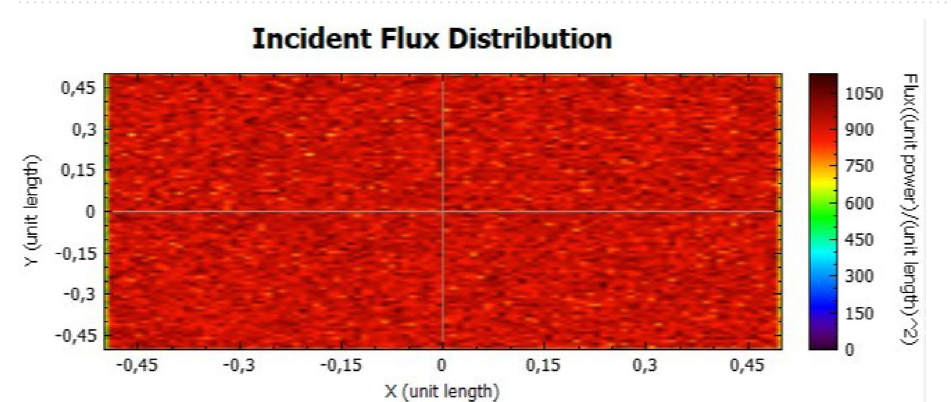
Figure 7. Output power in function of the reflectivity percentage.